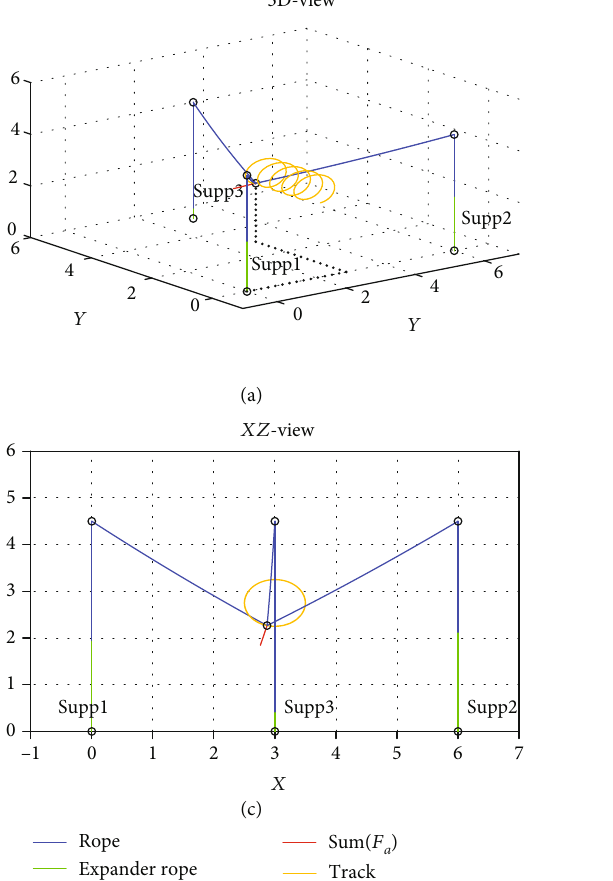
Figure 12: EAGLE ’ s trajectory 1 (in yellow) and the three ropes ( fi xed at the lander and led to the supporters). (a) 3D view of the motion. (b) XY view of the motion of EAGLE, where in-plane motion can be better visualized, with the lander that has to generate a force towards Y (in red). (c) XZ view of the motion of EAGLE: given the motion and the contributions almost identical of rope 1 and rope 2, it is possible to see that the X component of the force (in red) is very small compared to the Y - and Z - components. (d) YZ view of the motion of EAGLE, where again rope 3 generates a pulling force on EAGLE, as visible from the Y component in red (showing the force that EAGLE has to